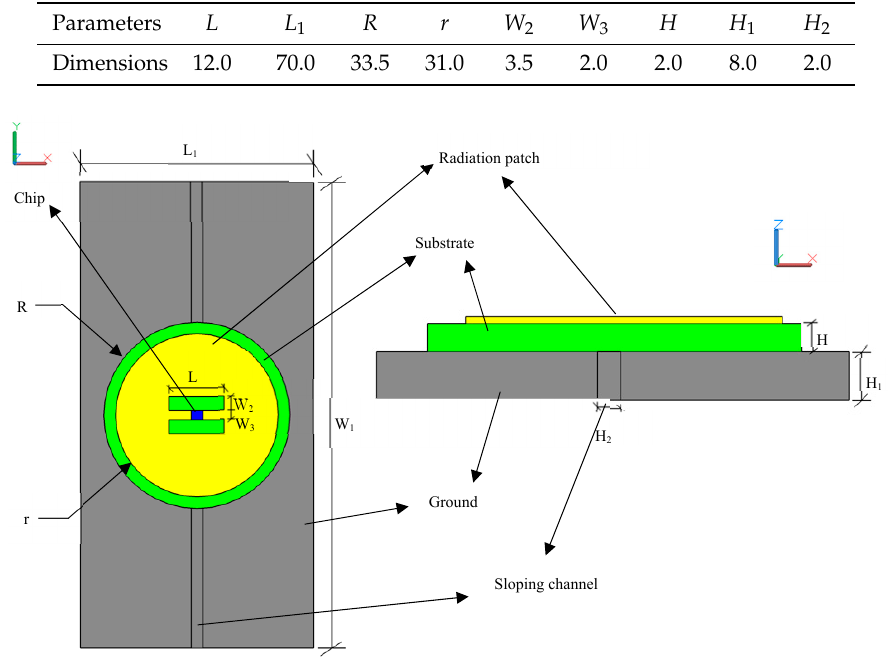
Figure 6. Diagram of the sensor’s specific parameters.